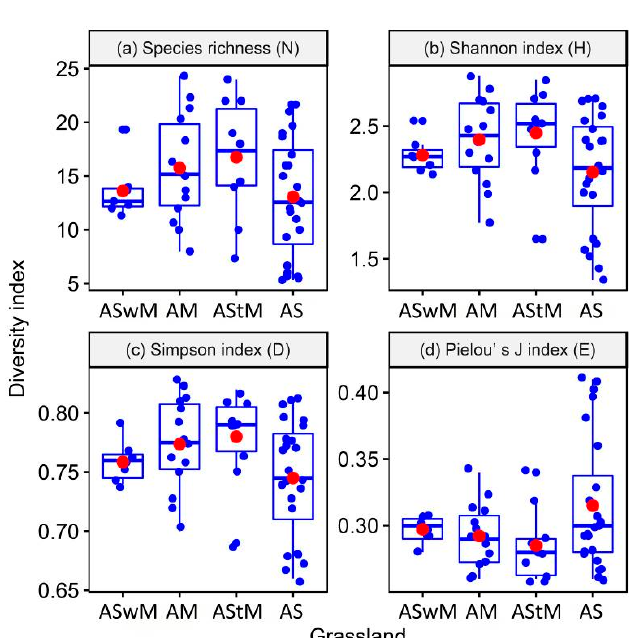
Figure 6. ( a ) Species richness, ( b ) Shannon index, ( c ) Simpson index and ( d ) Pielou’s J index of four types of alpine grasslands. Red dots represent mean value of different types of functional groups. Blue dots represent the value of all sampling sites (n = 55). The bold solid horizontal line means the median value. ASwM, AM, AStM and AS indicate alpine swamp meadow, alpine meadow, alpine steppe meadow and alpine steppe, respectively. Table 2. One-way ANOVA of pika burrows, pika density, vegetation richness indexes, fractional vegetation cover and bare patch area fraction among four types of alpine grasslands at plot scale. λ 2 and F are the results of multiple comparison of the Kruskal–Wallis H model and Tukey HSD model. Significant differences are indicated by P values. *, P < 0.05; ns, no significant difference. Variables